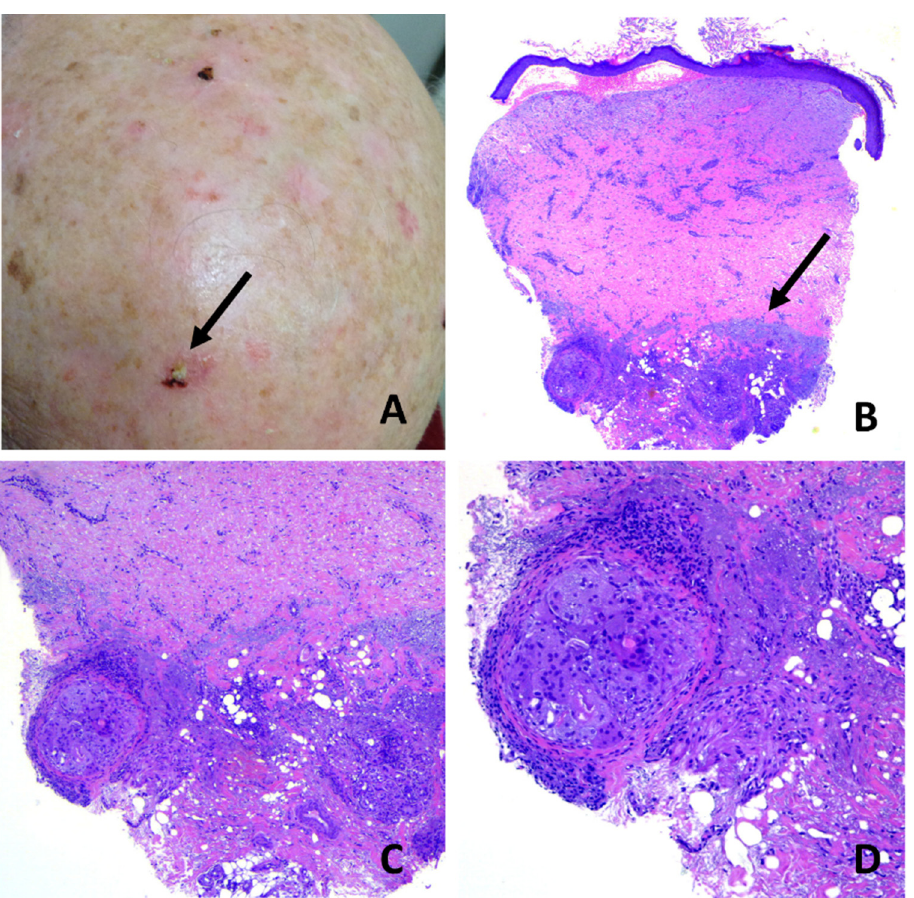
Figure 7. Erosive pustular dermatosis of the scalp; ( A ) chronic, long-standing EPDS with diffuse scarring alopecia. A solitary, erythematous, eroded and crusted plaque was biopsied in the suspicion of squamous cell carcinoma (arrow); ( B ) hemorrhagic blistering in the dermal–epidermal junction, subepidermal clefting and diffuse dermal fibrosis. Note elastotic material pushed down into the deep reticular dermis (arrow); ( C ) focal aggregates of macrophages and foreign-body giant cells containing small hair fragments within deep reticular dermis; ( D ) particular of C.